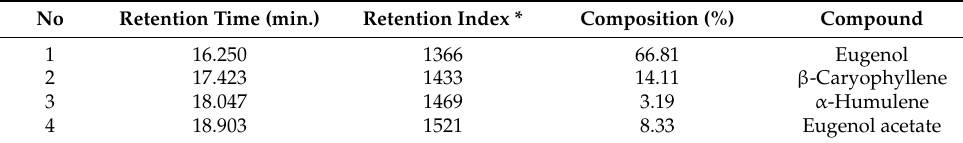
Table 1. Relative percentages of the main volatile components identified in CEO.